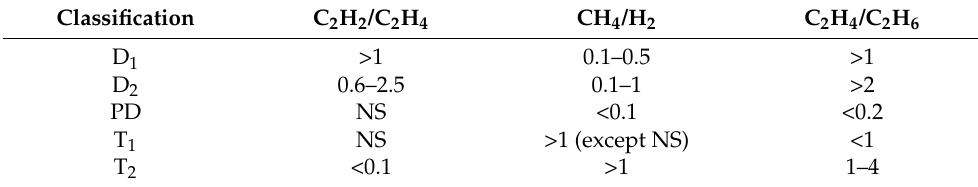
Table 6. DGA Diagnostic Form.